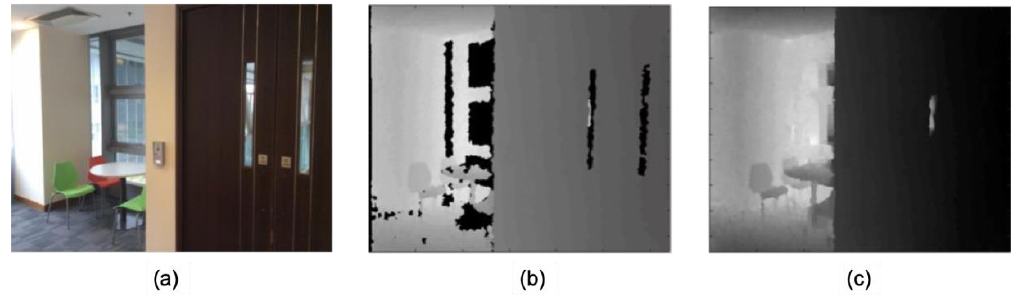
Figure 4. The example of ( a ) RGB image, ( b ) raw depth, and ( c ) filled depth.